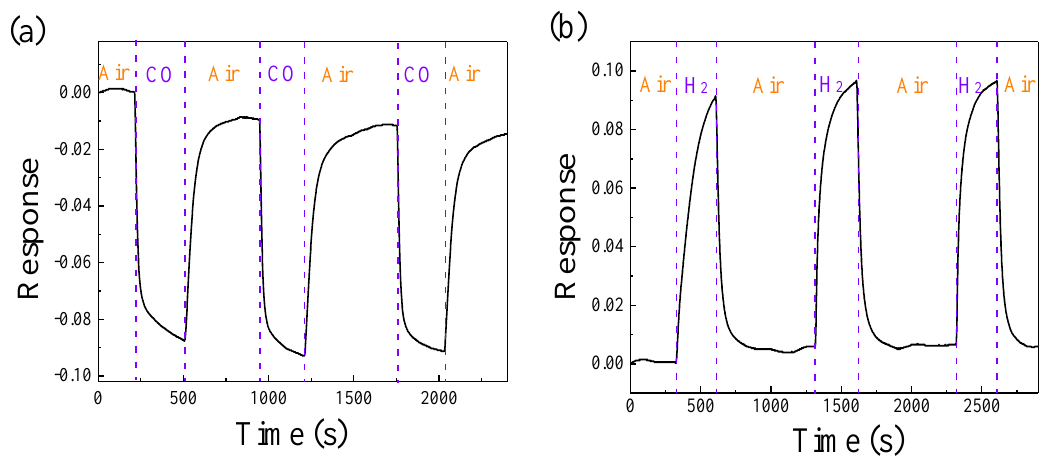
Figure 7. Three cycles of dynamic gas sensing response curve of ZnO–0.425NiO annealed at 550 °C to 400 ppm CO ( a ) and H 2 ( b ) at 350 °C.